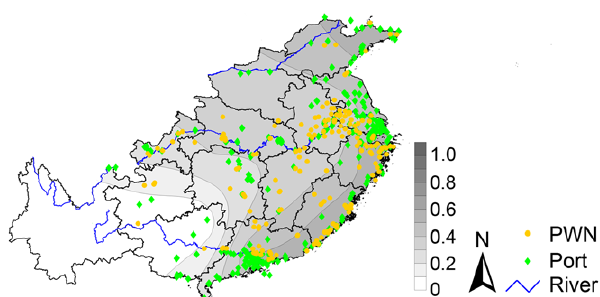
Figure 5. Contour mapping of the ratio of shared M.alternatus haplotypes ( R shr ) and the distribution of pinewood nematode (PWN) infested sites (yellow dots) and ports (green dots) within our study area in China after exclusion of the M.alternatus data from Guizhou and